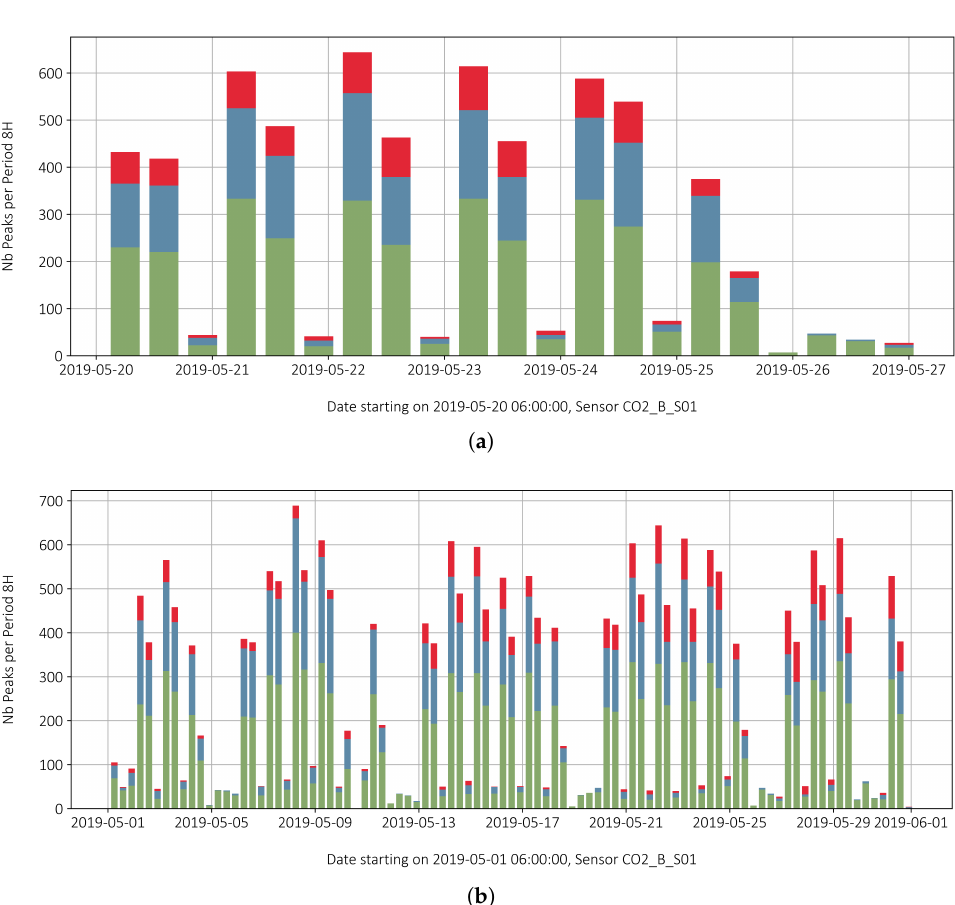
Figure 10. ( a ) Count of resampled peak strains for a duration of one week; and ( b ) resampled peaks for the entire month.